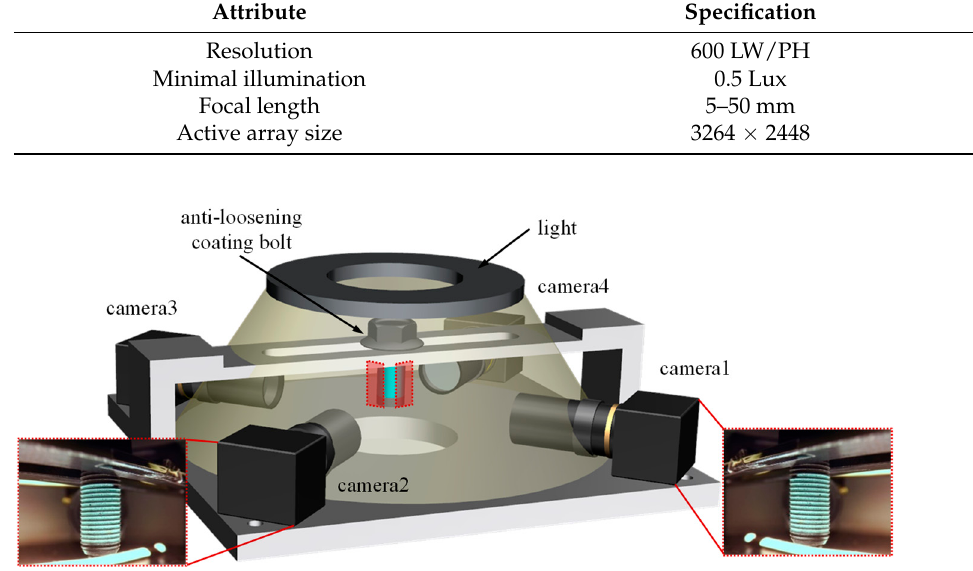
Figure 3. The data capture method. Table 1. Camera specifications.